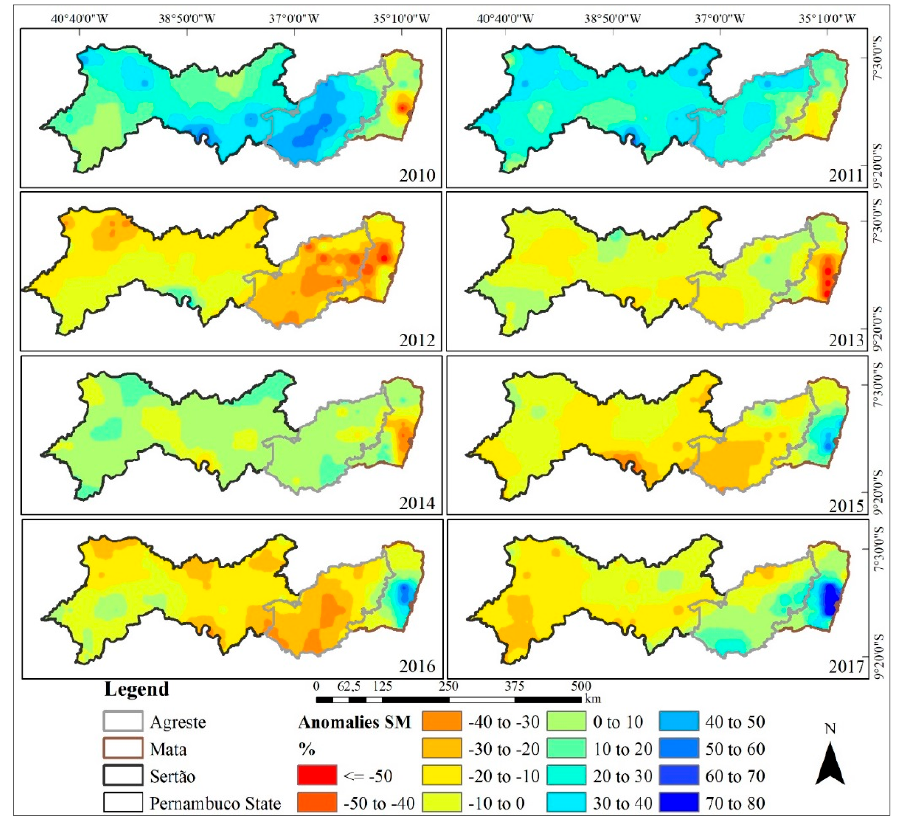
Figure 10. Soil moisture annual anomaly of each year in relation to the entire period of 2010 to 2017.